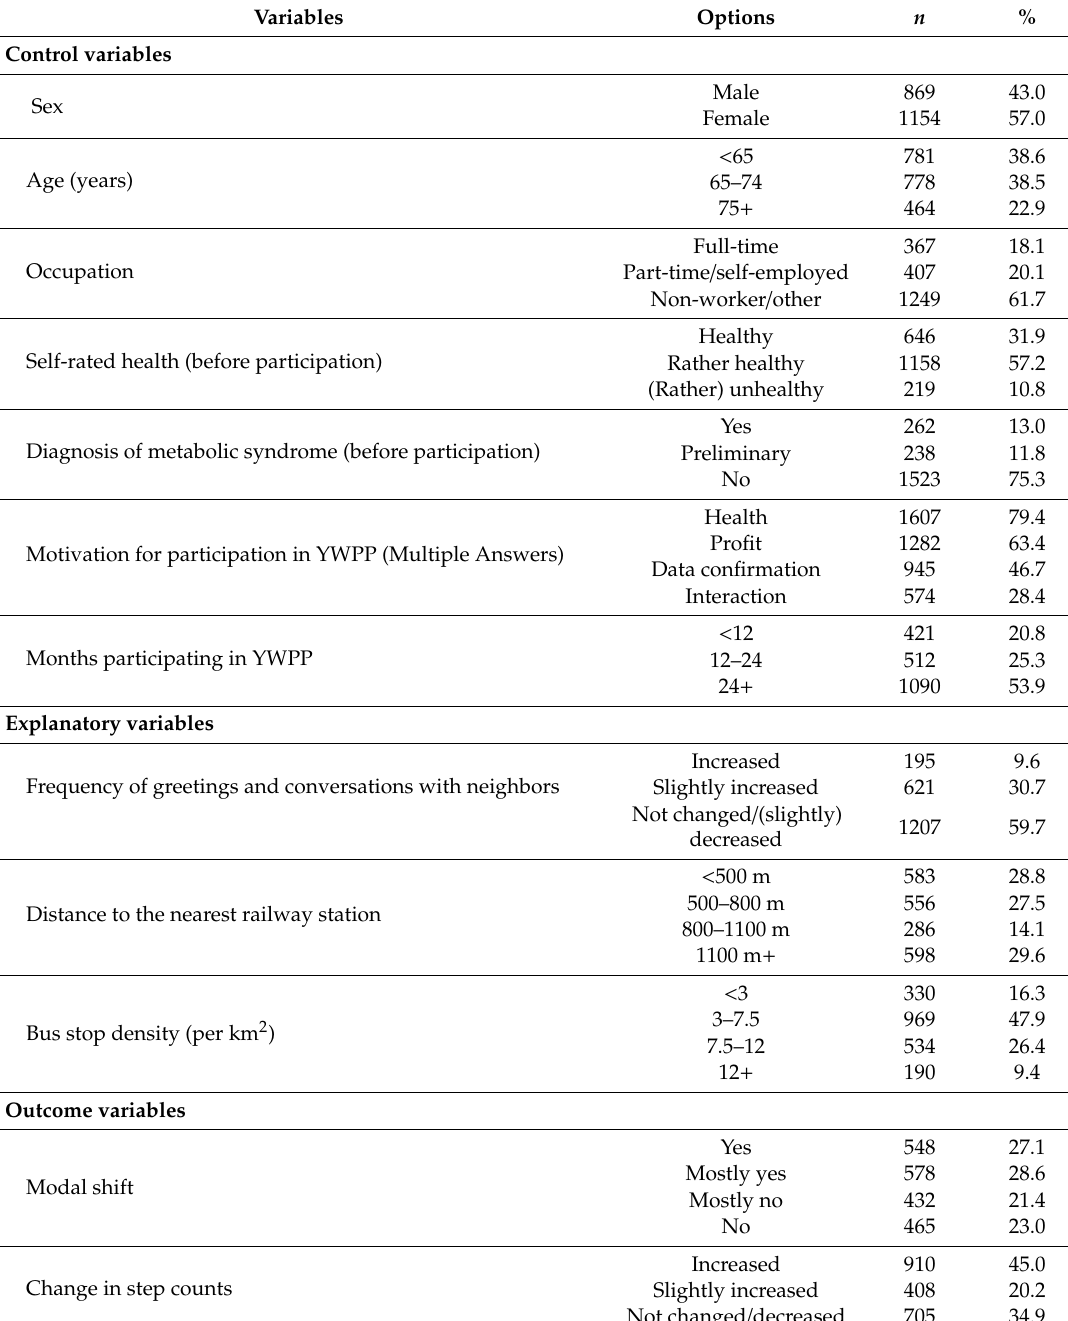
Table 1. Characteristics of the study samples and questionnaire results ( n =